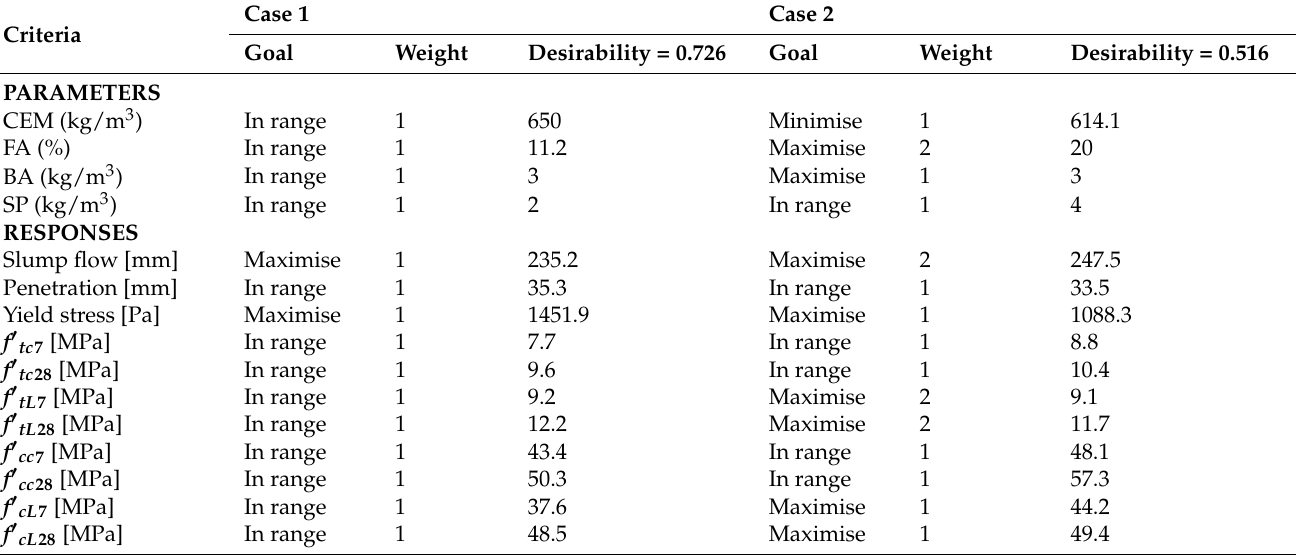
Table 10. Criteria and goals used for multi-objective